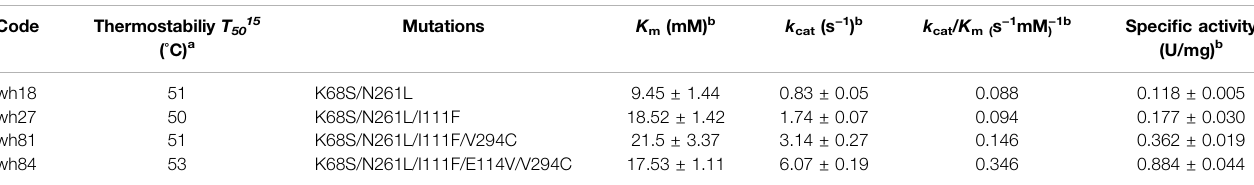
TABLE 3 | Thermostability and kinetic parameters of puri fi ed Sp AmDH mutants for substrate 1a. Code